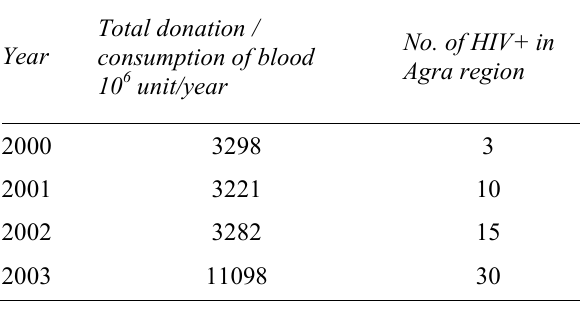
Table 1: Blood Bank Information